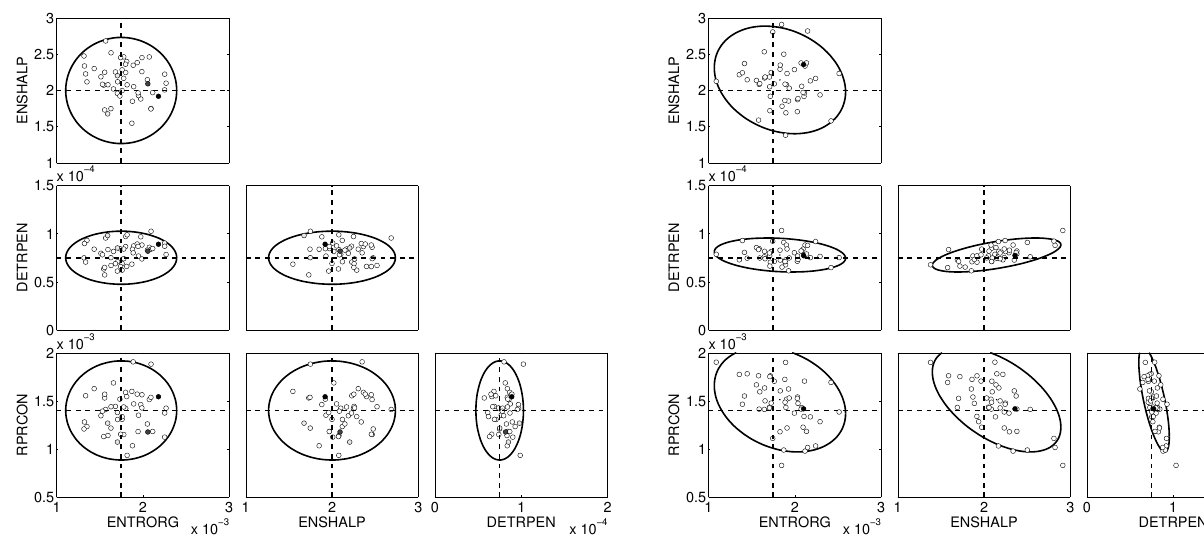
Fig. 2b. As Fig. 2a, but after 177 consecutive ensembles; the small markers are the proposed parameter values at step 177. (Fig. 2b), the covariance ellipses appear at the new